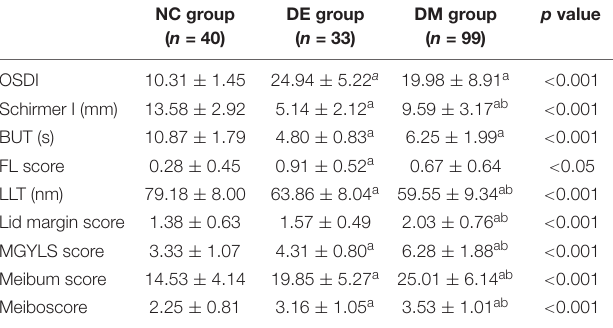
TABLE 2 | The tear film and meibomian gland parameters in different